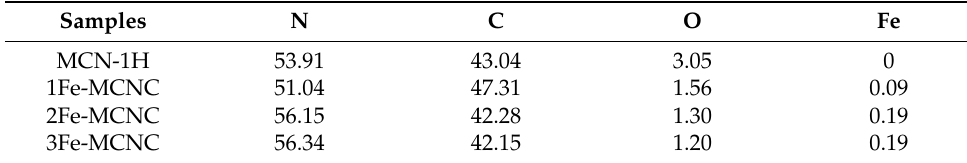
Figure 1. FE ‐ SEM images: ( a , b ) MCN ‐ 1H, ( c , d ) 1Fe ‐ MCNC, ( e , f ) 2Fe ‐ MCNC, ( g , h ) 3Fe ‐ MCNC, ( i , j ) Figure 1. FE-SEM images: ( a , b ) MCN-1H, ( c , d ) 1Fe-MCNC, ( e , f ) 2Fe-MCNC, ( g , h ) 3Fe-MCNC, ( i , j ) EDS spectra of MCN-1H and 2Fe-MCNC, and ( k – o ) FE-SEM image and elemental mapping of MCNC. 2Fe-MCNC. Table 1. Elemental composition of the synthesized